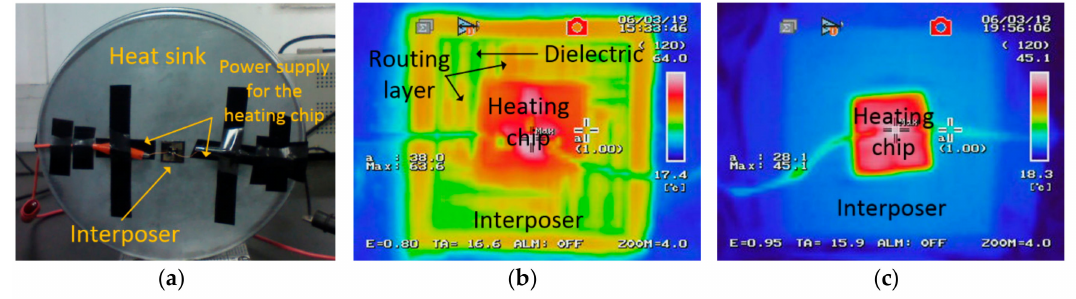
Figure 11. ( a ) The thermal distribution test sample. ( b ) Thermal distribution of the interposer with PI dielectric. ( c ) Thermal distribution of the interposer with the proposed composite